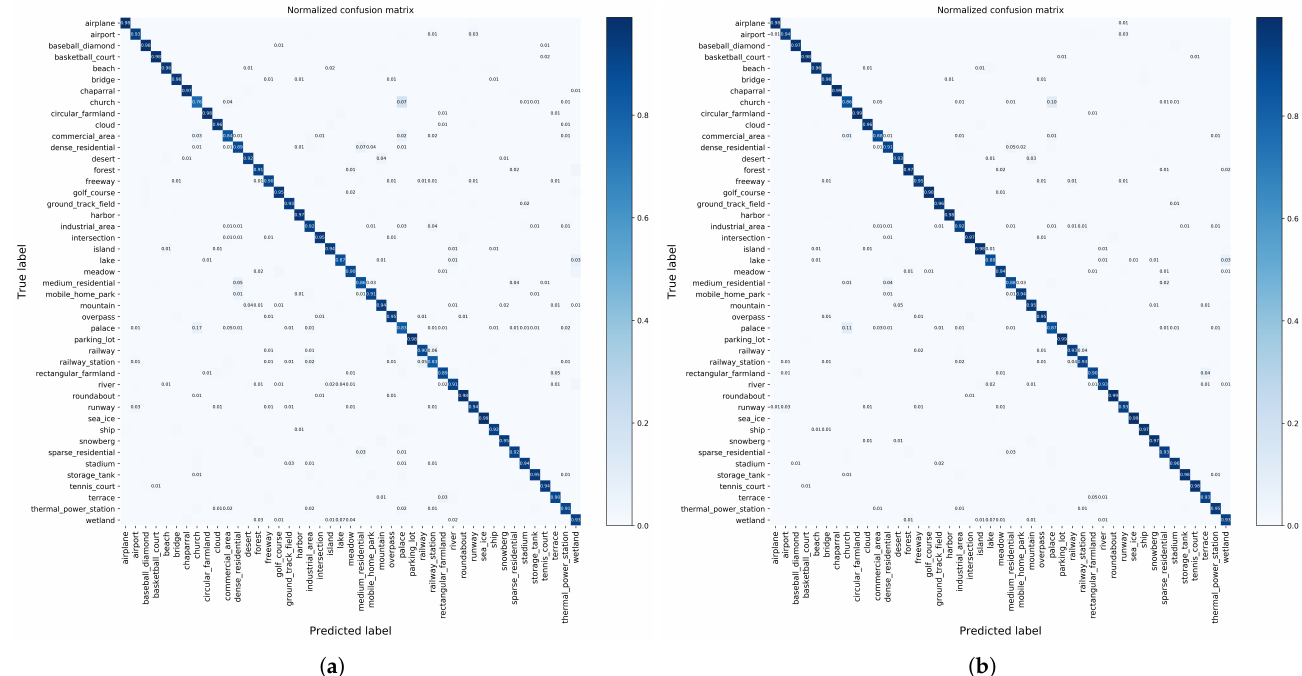
Figure 10. CMs on the NWPU-RESISC45 dataset. ( a ) Training ratio = 10% (accuracy = 92.44%). ( b ) Training ratio = 20% (accuracy =